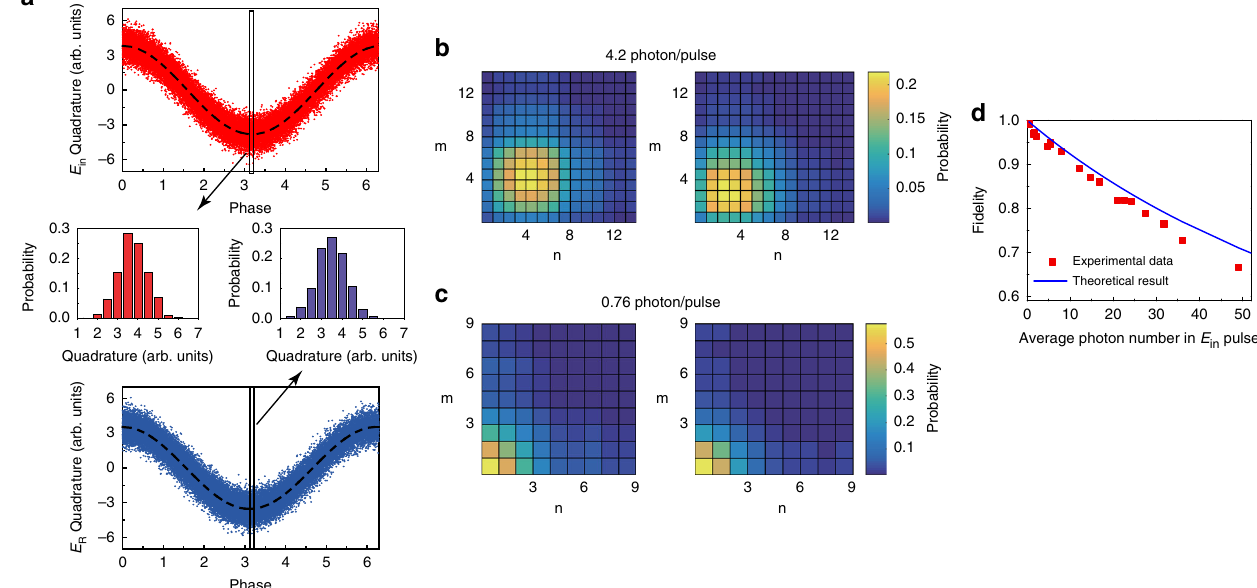
Fig. 3 Fidelity of the Raman memory. a Quadrature amplitudes of the input and output signal pulses at an average of 7.9 photons/pulse. Insets are the probability distributions of the E in and E R quadrature values at the indicated phase. The density matrices of the input and output signal pulses at 4.2 ( b ) and 0.76 ( c ) photons/pulse on average. d Fidelity as a function of the number of photons contained in the input signal pulse. The red squares show the experimental data, and the black line shows the theoretical result. The error bars correspond to one standard deviation caused by the measurement by h i p ffiffiffiffiffi Þ 2 ð 1 (cid:3) η 24 , which shows that if η F ¼ 1 = 1 þ N T < 1, the E in T